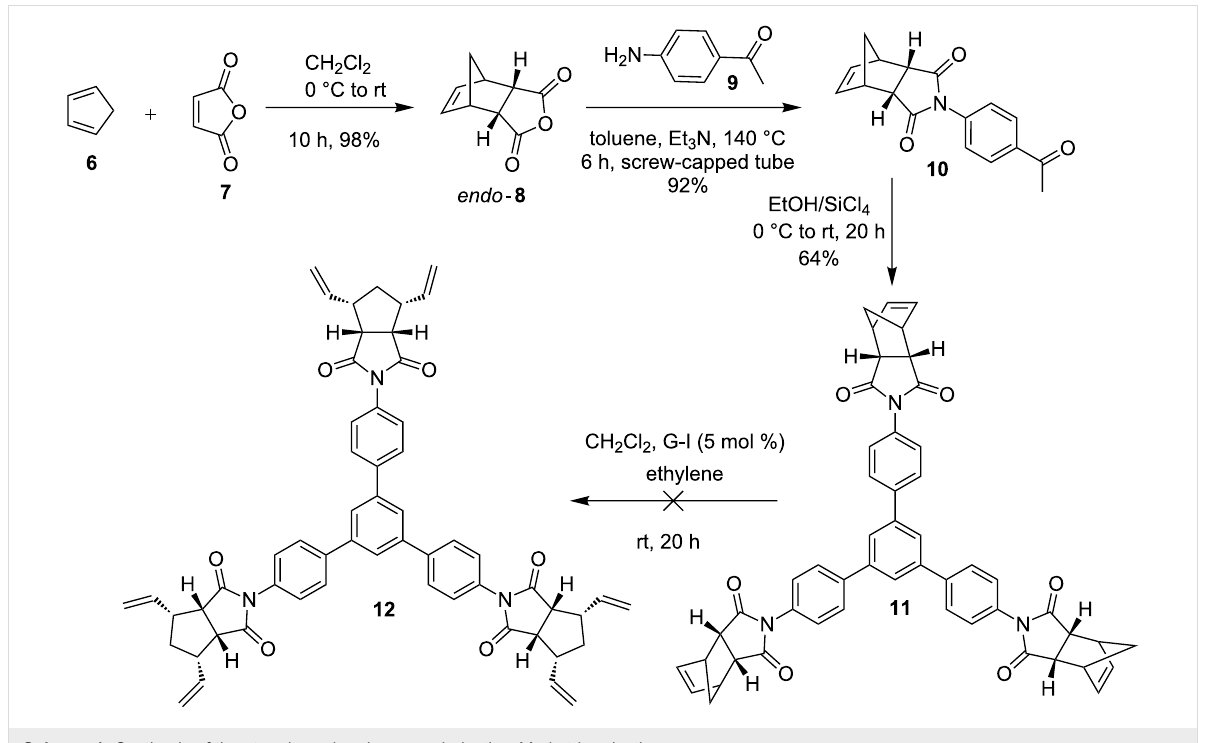
Scheme 1: Synthesis of the star-shaped norbornene derivative 11 via trimerization.